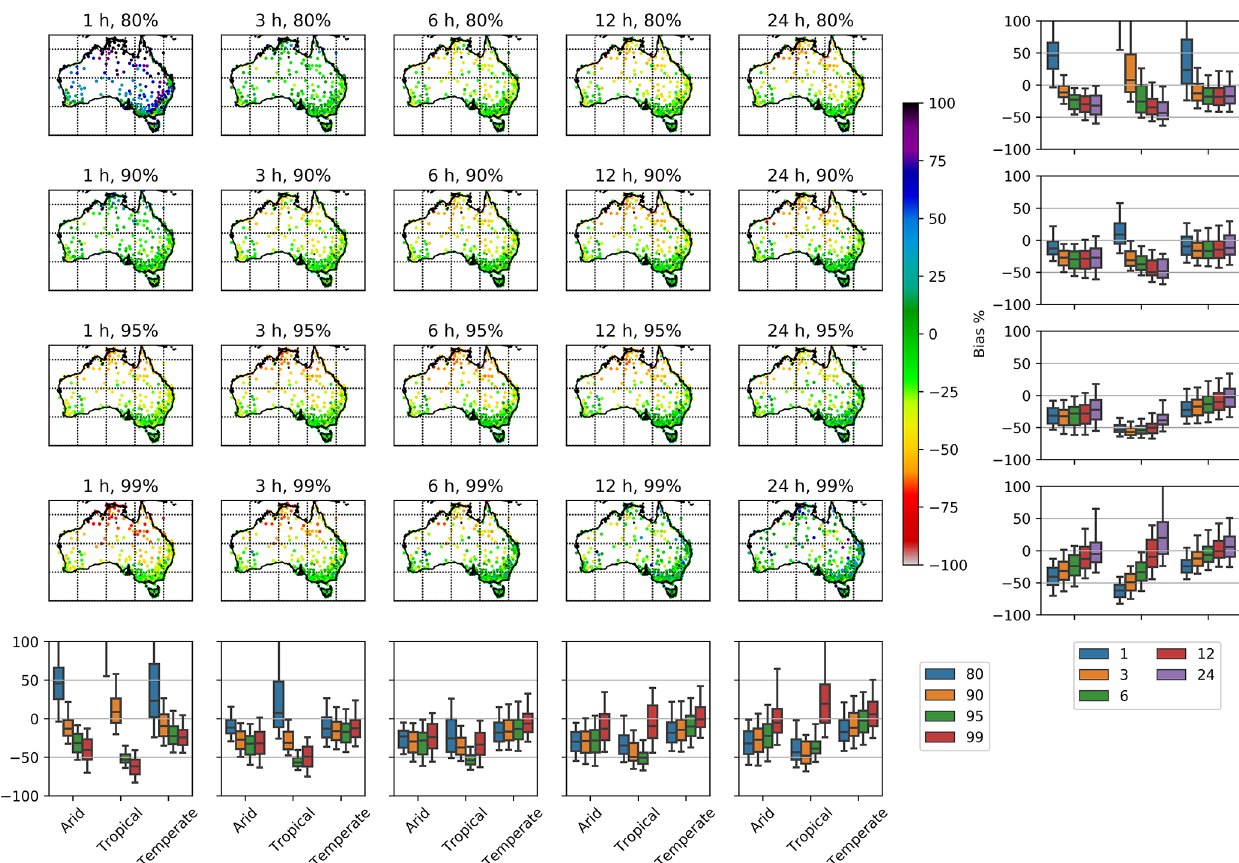
Figure 2. Percentage bias in precipitation at quantiles (rows) and accumulations (columns). The box plots represent the summary of percent- age bias across climatic zones for respective rows and columns. Each box in the box plot represents 25th–75th-quantile values, the horizontal line in the box represents the median, and whiskers represent the 5th–95th quantiles.